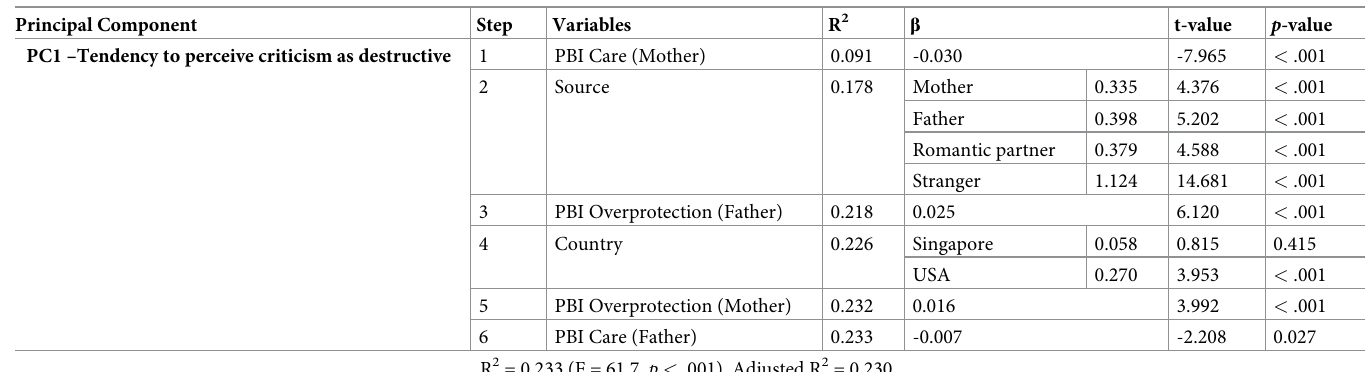
Table 3. Table of final model in stepwise regression for PC1. Principal Component